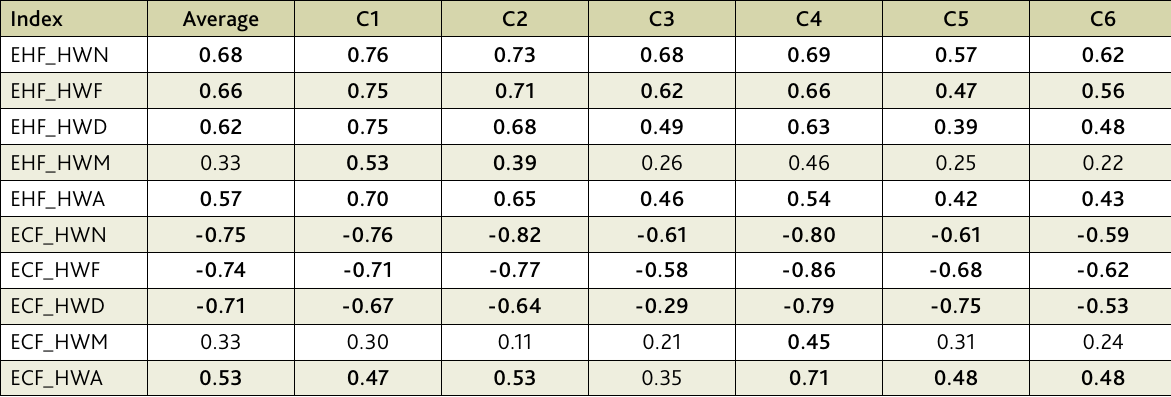
Table 6. Kendall’s τ coefficients between the EAi and the ET-SCI HW and CW indices. In bold, significance level (p-value) of <